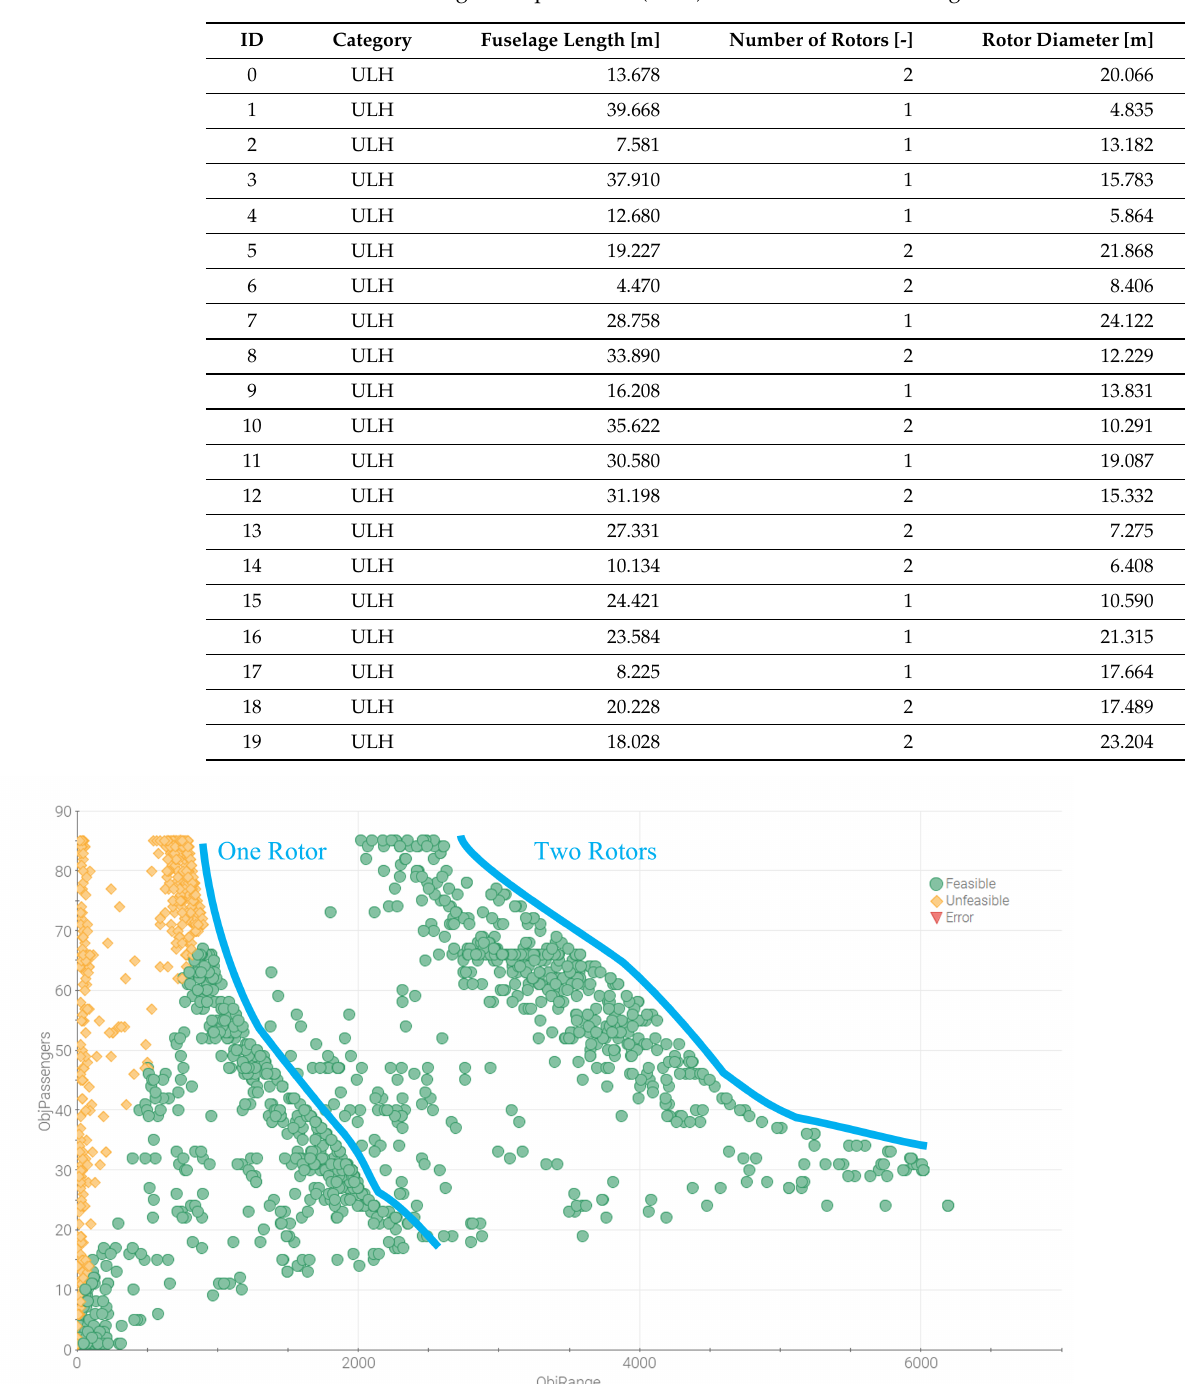
Table 4. The utilized design of experiments (DOE) with its 20 different designs.